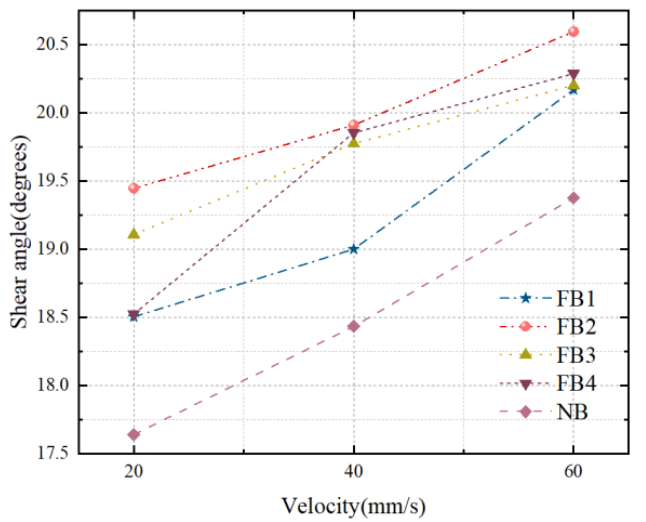
Figure 11. Cutting angle of broaches with different surfaces.